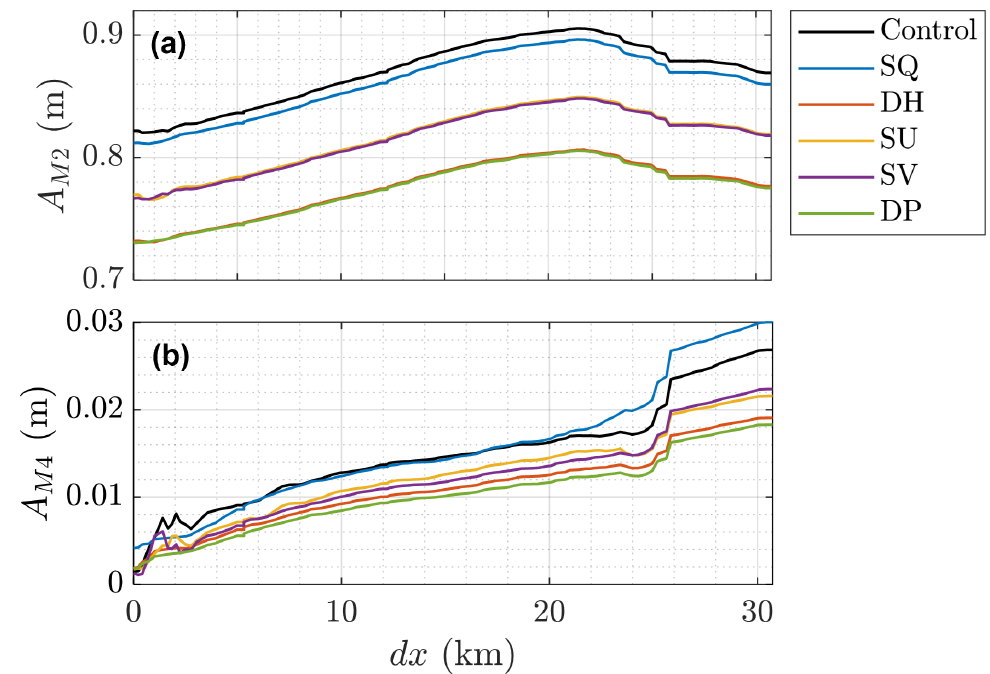
Figure 7. Change in tidal constituent amplitude for ( a ) M2 and ( b ) M4 as a function of along-channel distance from inlet dx (see Figure 1) for distance markers.